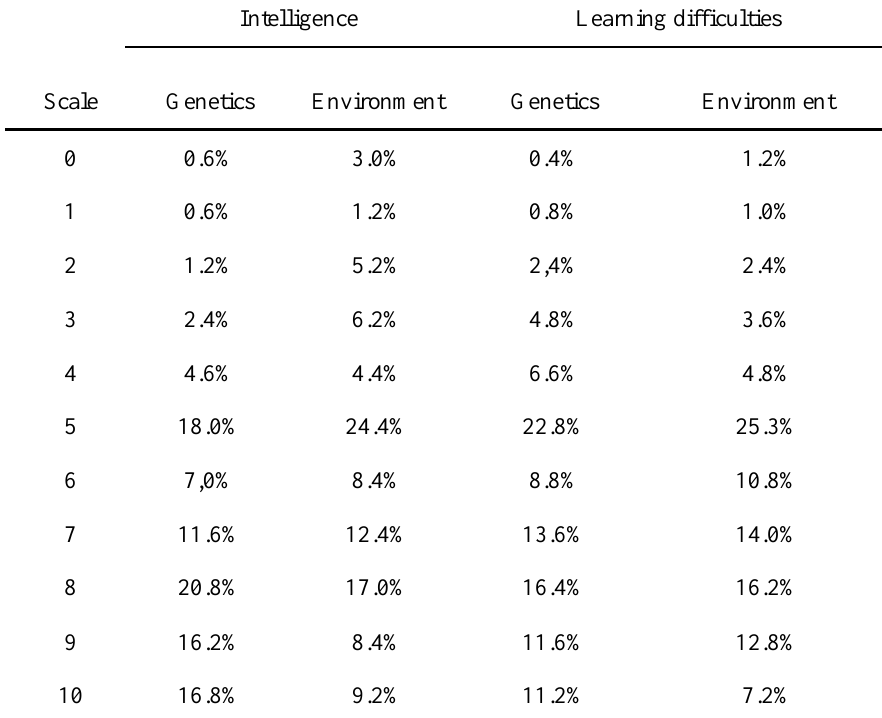
Percentage of responses of the numerical scales from 0 to 10 on the influence of genetic and environmental influence on intelligence and learning difficulties